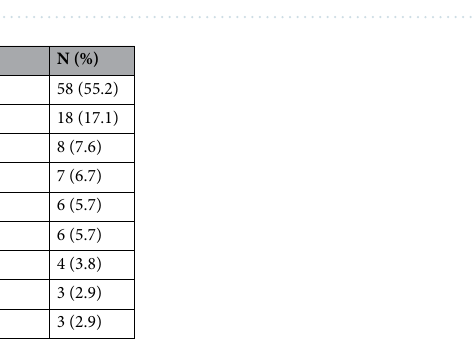
Table 2. Reason for NTZ discontinuation. 105 patients discontinued NTZ. Those patients who stopped treatment due to pregnancy are planned to restart NTZ after delivery. JCV positive positive for Anti-JC-Virus antibodies, SPMS secondary progressive multiple sclerosis, NAbs neutralizing antibodies, PML progressive multifocal leukoencephalopathy.